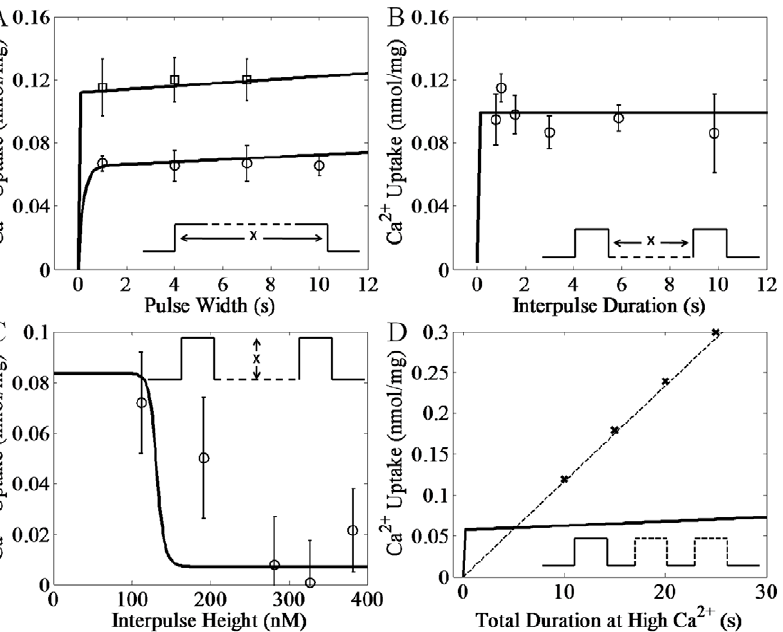
Figure 2. Simulations of the experimental data of Ca 2 + uptake facilitated by RaM in liver. The corresponding pulse waveform for each experiment is shown in each panel. A) The model reproduced the measured Ca 2 + uptake responses to pulses of Ca 2 + at varying pulse heights and durations. The circles and squares represent the Ca 2 + uptake from pulses at pulse heights of 171 and 281 nM, respectively, with an increasing pulse duration. B) The model reproduced the measured Ca 2 + uptake response to a second pulse of Ca 2 + following a previous pulse of the same magnitude at varying interpulse durations. The circles represent the Ca 2 + uptake from a second pulse immediately after and up to 10 seconds after the first pulse. Both pulses were 5 s in duration at a pulse height of 421 nM with an interpulse height of 50 nM. C) The model reproduced the measured Ca 2 + uptake response to a second pulse of Ca 2 + following a previous pulse of the same magnitude at varying interpulse heights at a fixed interpulse duration of 1 second. The circles represent the Ca 2 + uptake from the second pulse at a pulse height of 480 nM. Each pulse duration was 10 s. The Ca 2 + uptake values were adjusted to compensate for CU activity to set the minimum uptake to be zero. D) The model reproduced the enhanced Ca 2 + uptake response to multiple, short pulses versus a single, long pulse. The dashed line follows the trend of increasing Ca 2 + uptake for in an increasing the number of pulses. All simulation results are either shown as x’s or a solid line depending on the nature of the simulation. In all cases, the prepulse height for each pulse was near 50 nM.